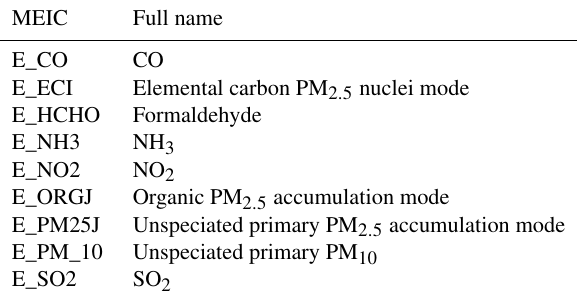
Table 3. Summary of emission inventory